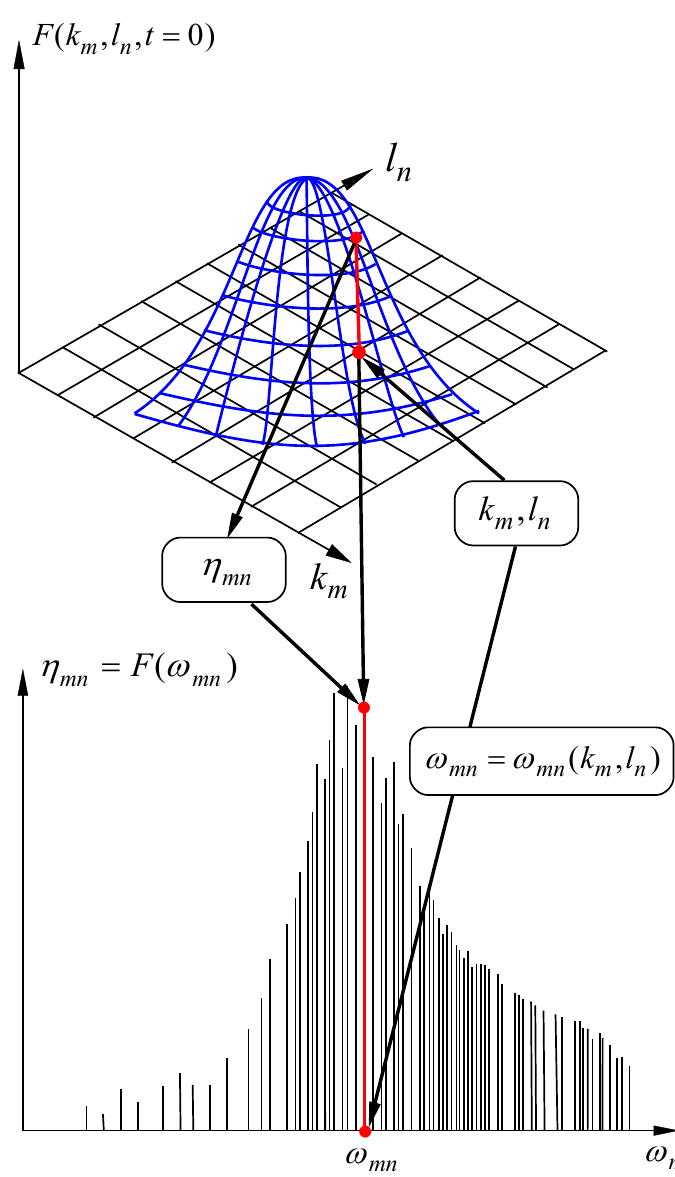
Figure 20. Two ‐ dimensional ocean surface wave spectrum at an instant in time, Figure 20. Two-dimensional ocean surface wave spectrum at an instant in time, F ( k m , l n , t = 0 ) = η F ( x m , y n , t  0)   mn ( x m , y n ) , on a wavenumber grid ( k , l ) , which is commensurable with m n mn ( k m , l n ) on a wavenumber grid ( k m , l n ) , which is commensurable with wavenumber resolution ( ∆ k , ∆ l ) (upperpanel)andtheassociatedfrequencyspectrumwithincommensurablefrequencies(lower wavenumber resolution (  k ,  l ) (upper panel) and the associated frequency spectrum with panel). Every wavenumber pair ( k m , l n ) (upper panel) maps to the frequency ω mn = ω mn ( k m , l n ) (via the incommensurable frequencies (lower panel). Every wavenumber pair ( k m , l n ) (upper panel) maps dispersion relation, lower panel): Therefore, the frequencies ω mn = ω mn ( k m , l n ) are incommensurable to the frequency  mn   mn ( k m , l n ) (via the dispersion relation, lower panel): Therefore, the and each is uniquely associated with the spectral amplitudes η mn in Equations (165), (166) and frequencies  mn   mn ( k m , l n ) are incommensurable and each is uniquely associated with the spectral amplitudes  mn in Eqs. (165, 167, 168).